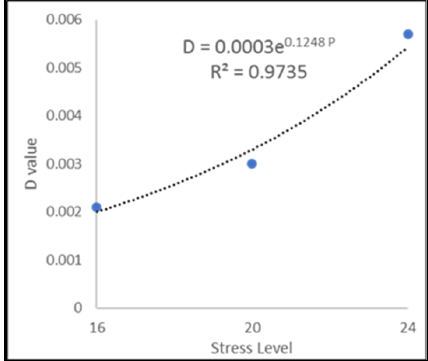
Figure 26. Plastic strain per cycle as a function of dwelling time curves at various stress levels.